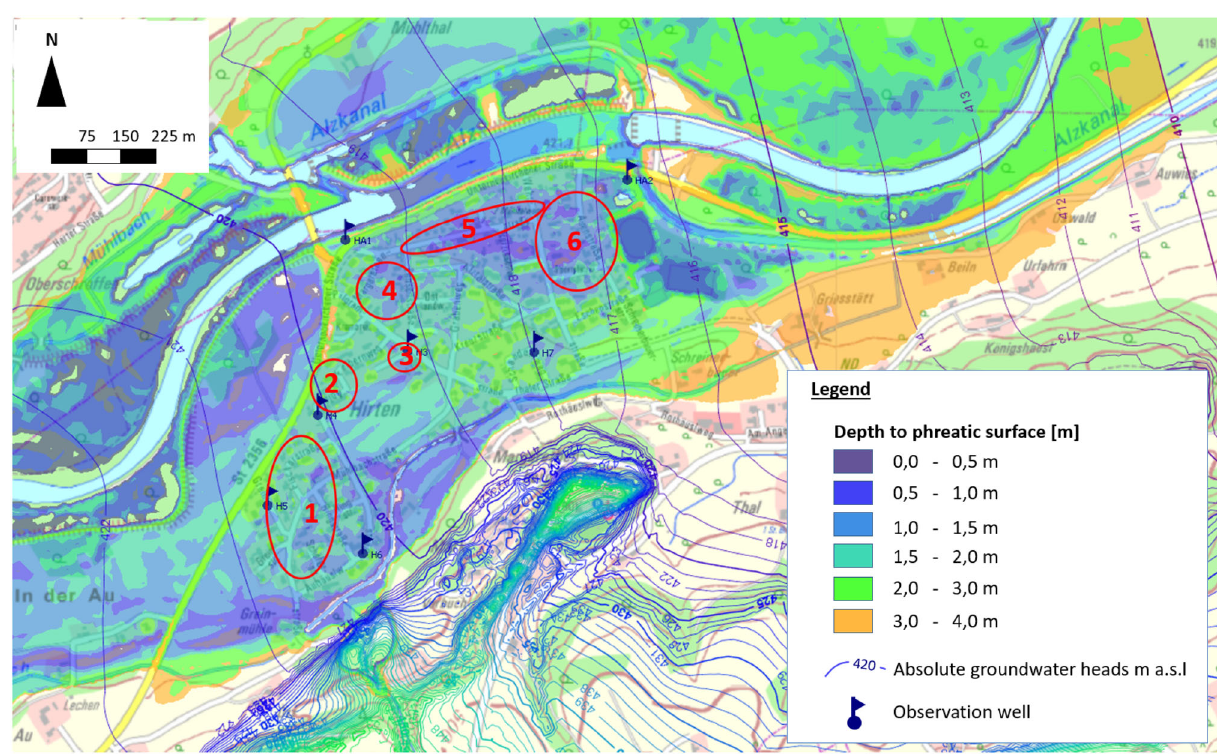
Fig. 9 Modeled groundwater levels for the 2013 event and without the planned dike overlapped with the cases of damage zones (red circles)